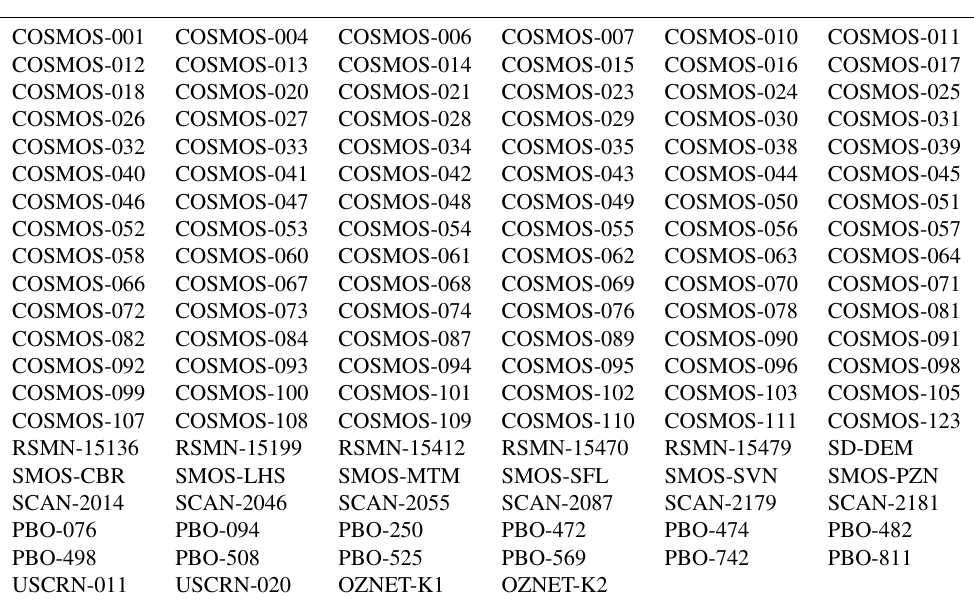
Figure 8. Scatters of six in situ sites (horizontal coordinate refers to the in situ data; vertical coordinate denotes the reconstructing data). Table 2. 124 selected soil moisture stations from the ISMN (2002–2022) for validating SGD-SM